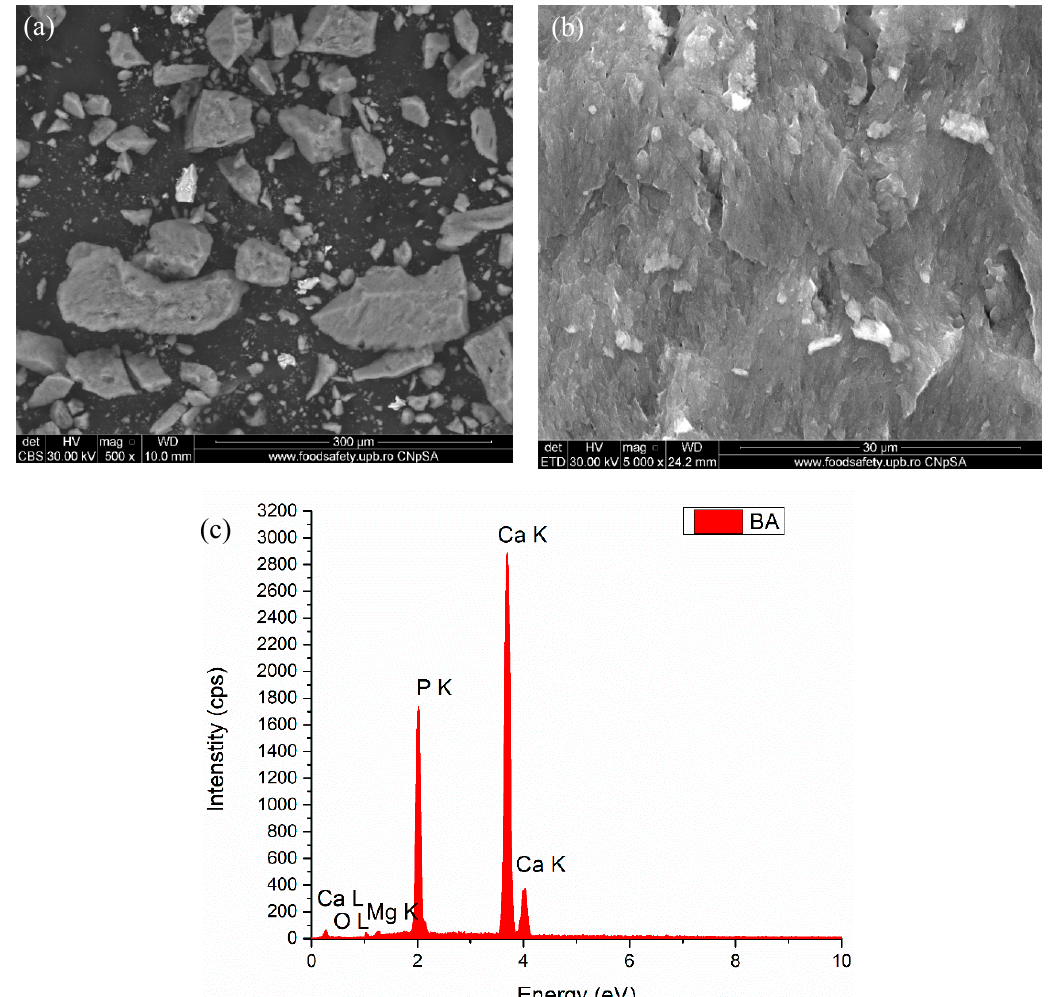
Figure 5. SEM micrographs ( a, b ) and EDS analysis spectrum ( c ) of bovine bone ash (BA).